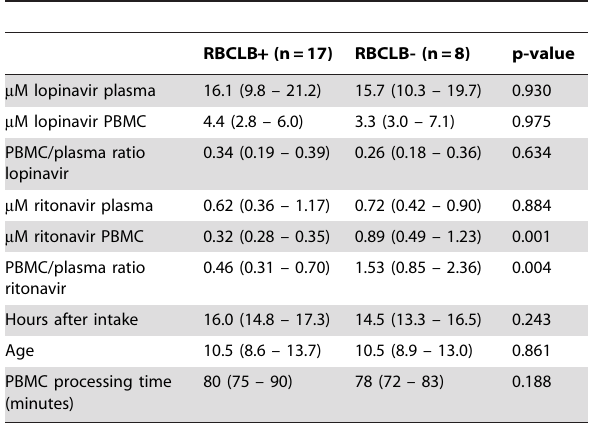
Table 3. Plasma and intracellular concentrations of lopinavir and ritonavir in HIV-1 infected children.